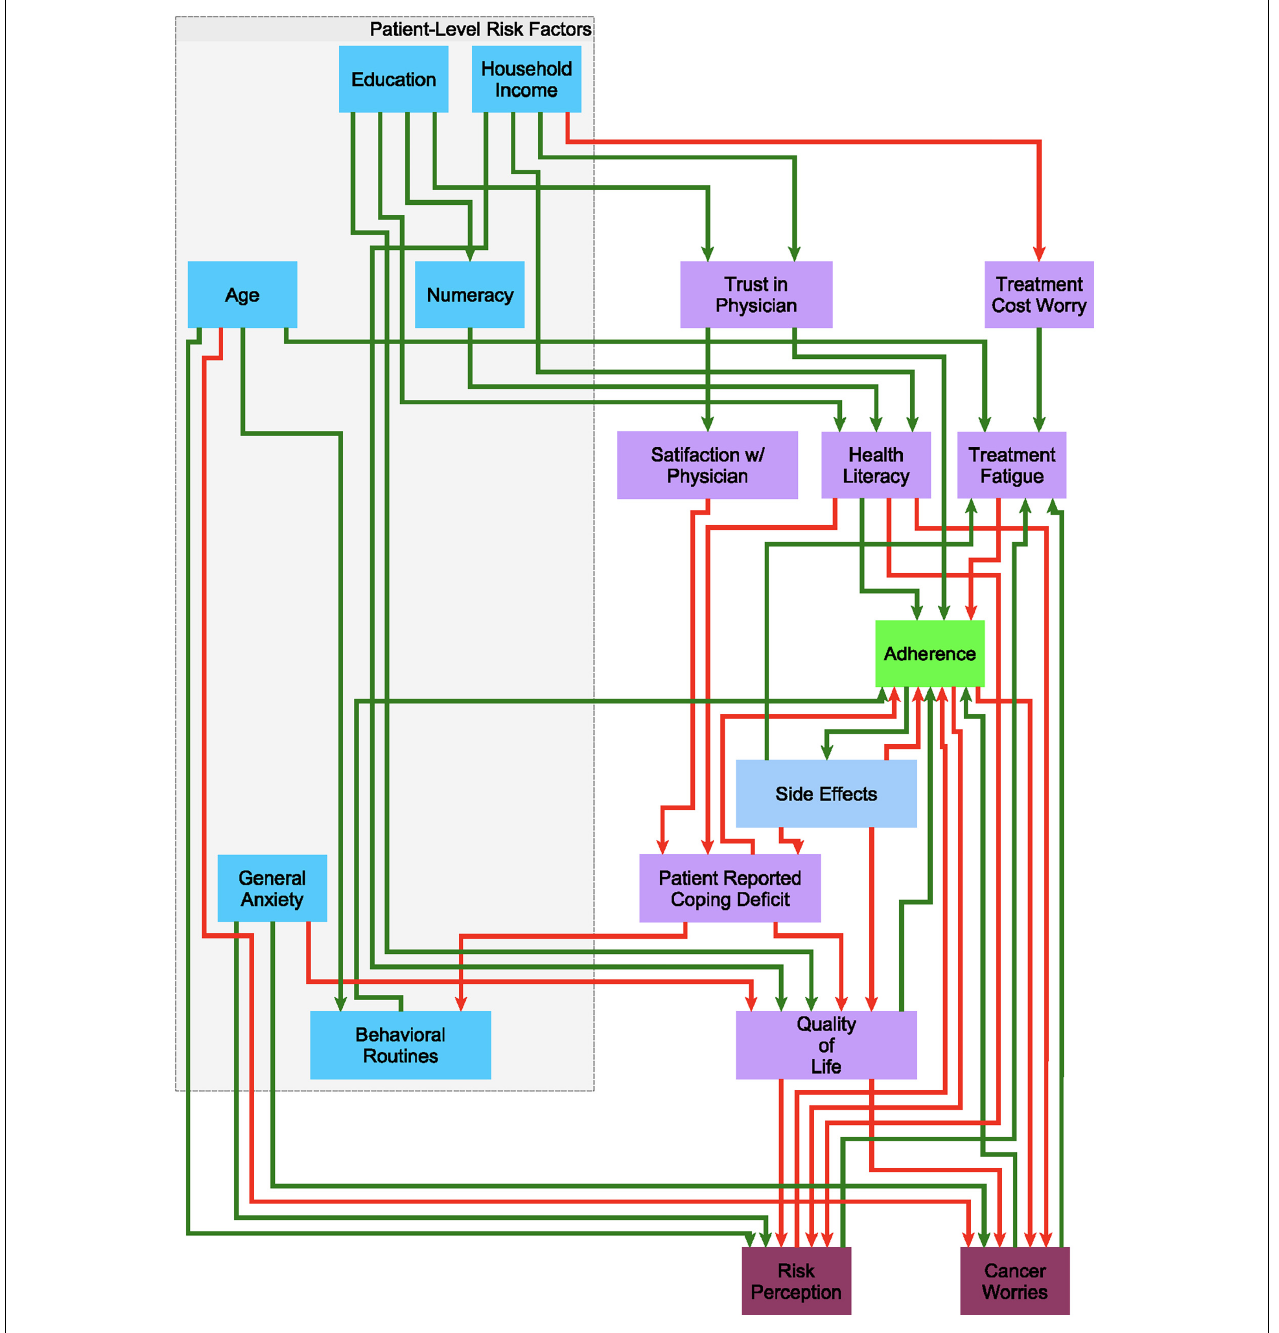
FIGURE 1 | A putative causal behavioral logic circuit supporting adherence to endocrine treatment (ET). A circuit model connecting 18 behavioral and demographic factors through 43 causal regulatory interactions describing the promotion (green arrows) or inhibition (red arrows) of one factor by another in the decision to alter adherence to ET as posited based on clinical